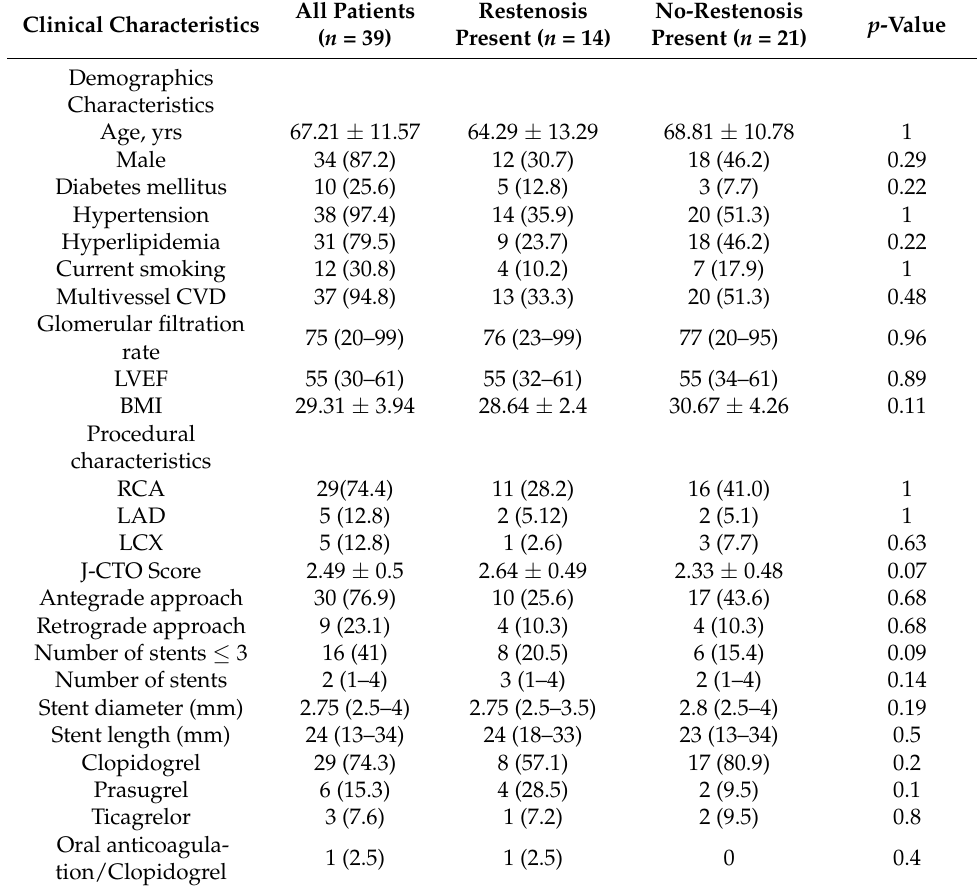
Table 1. Demographic and procedural